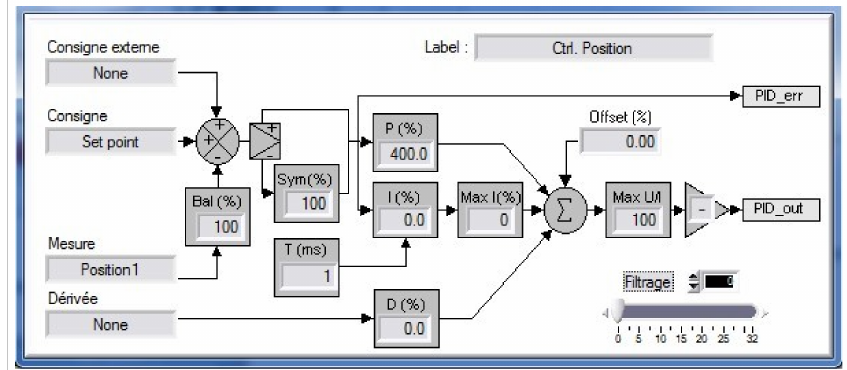
Figure 13. Block diagram of the Quiri PID controller.